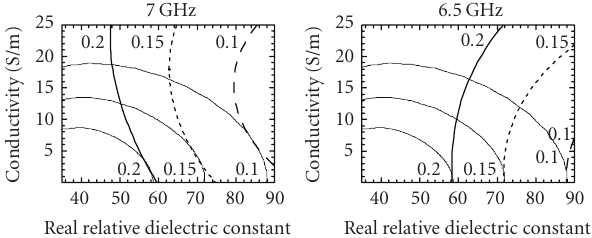
The values for real relative dielectric constant ε (cid:4) tivity σ , as a function of frequency, are plotted in Figure 2.